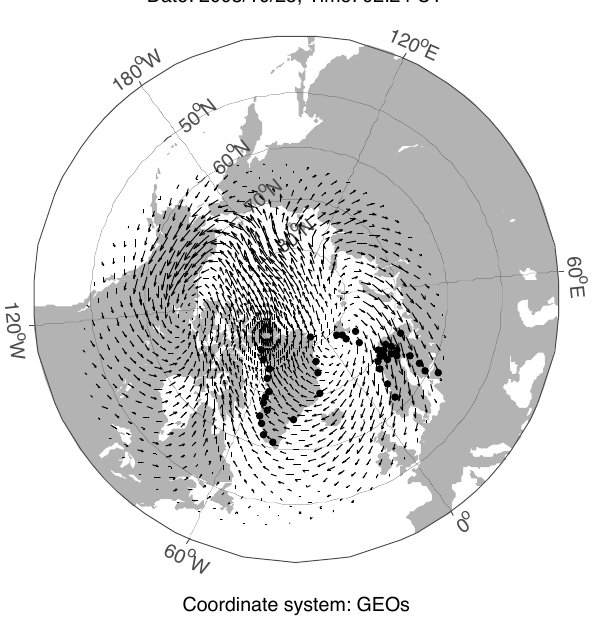
Fig. 3. Snapshot of the horizontal ionospheric currents given by the BATS-R-US. Dots indicate the locations to which the ground fields are computed and from which the measured ground magnetic field data was obtained. The date and the time of the snapshot is indicated in the title of the